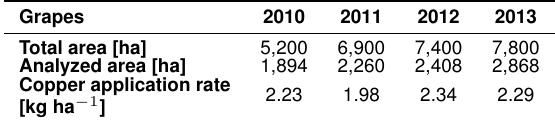
Table 3. Average copper application rates [pure copper